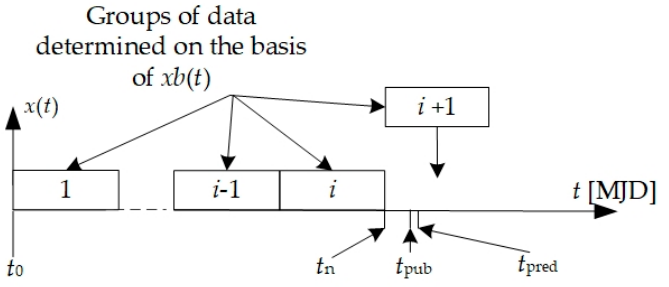
Figure 3. A method of constructing a time series based on the xb ( t ) values published by BIPM.